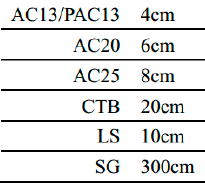
Figure 9. Structure of the pavement. CTB: cement treated base; LS: lime-stabilized soil; SG: subgrade.